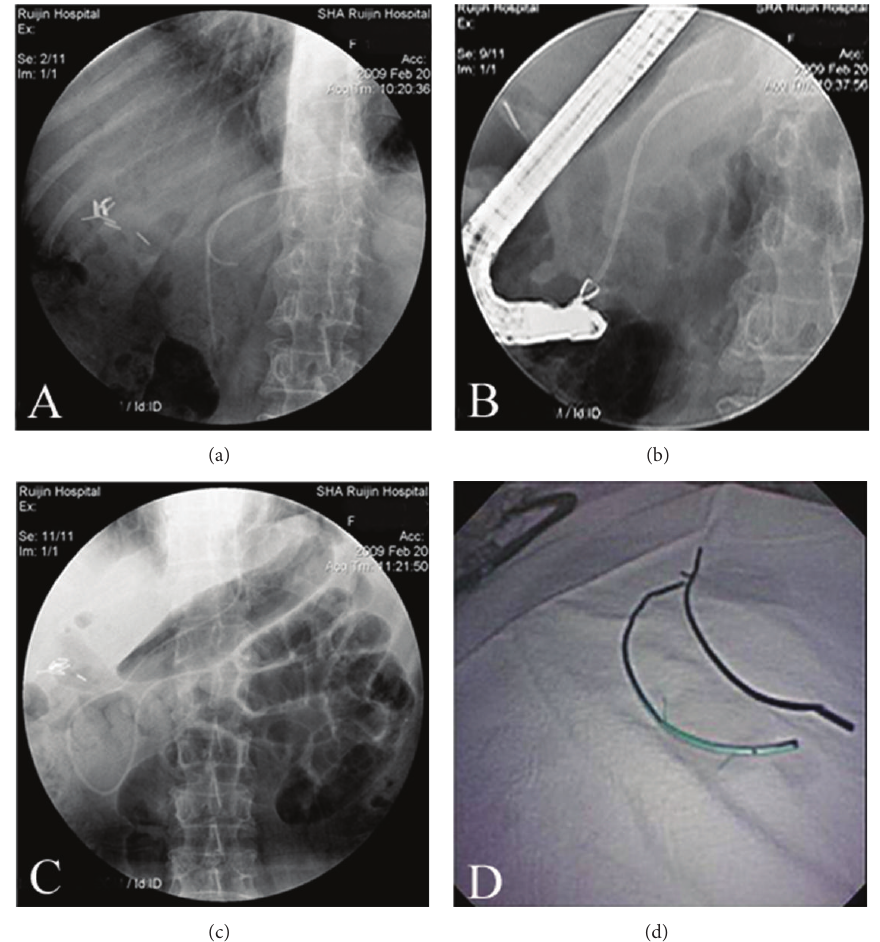
Figure 1: (a) Fluoroscopic view showing two pancreatic duct stents, with one migrated into the pancreatic duct. (b) Fluoroscopic view of stent extraction with grasping forceps after the tip of the stent has been pulled out of the papilla through balloon catheter. (c) Fluoroscopic view showing endoscopic nasopancreatic drainage has been performed. (d) Endoscopic demonstration of retrieved